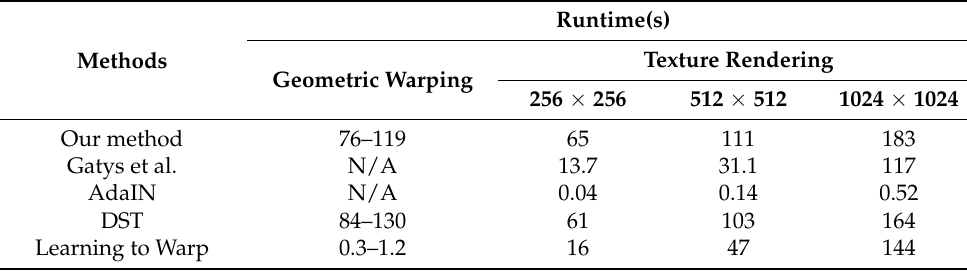
Table 2. Comparison between the runtimes (in seconds) of different